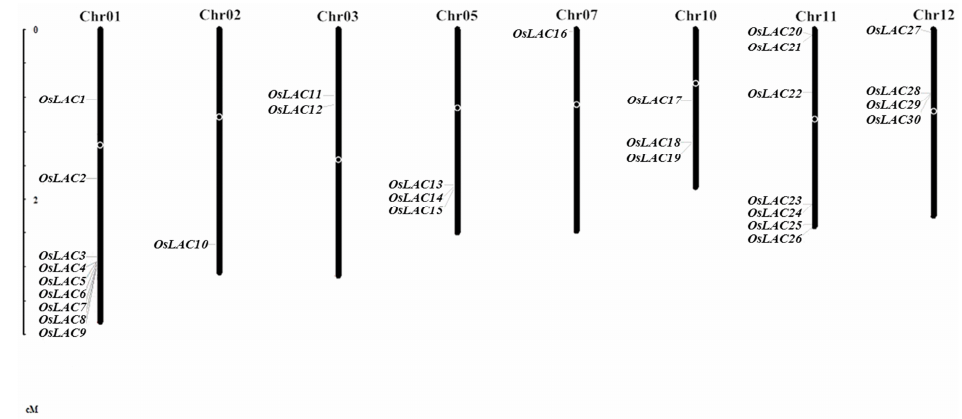
Figure 1. Chromosome map depicting location of rice laccase genes. Table 1. Gene locus and prediction of N-terminal signal peptides and glycosylation sites of rice laccases.